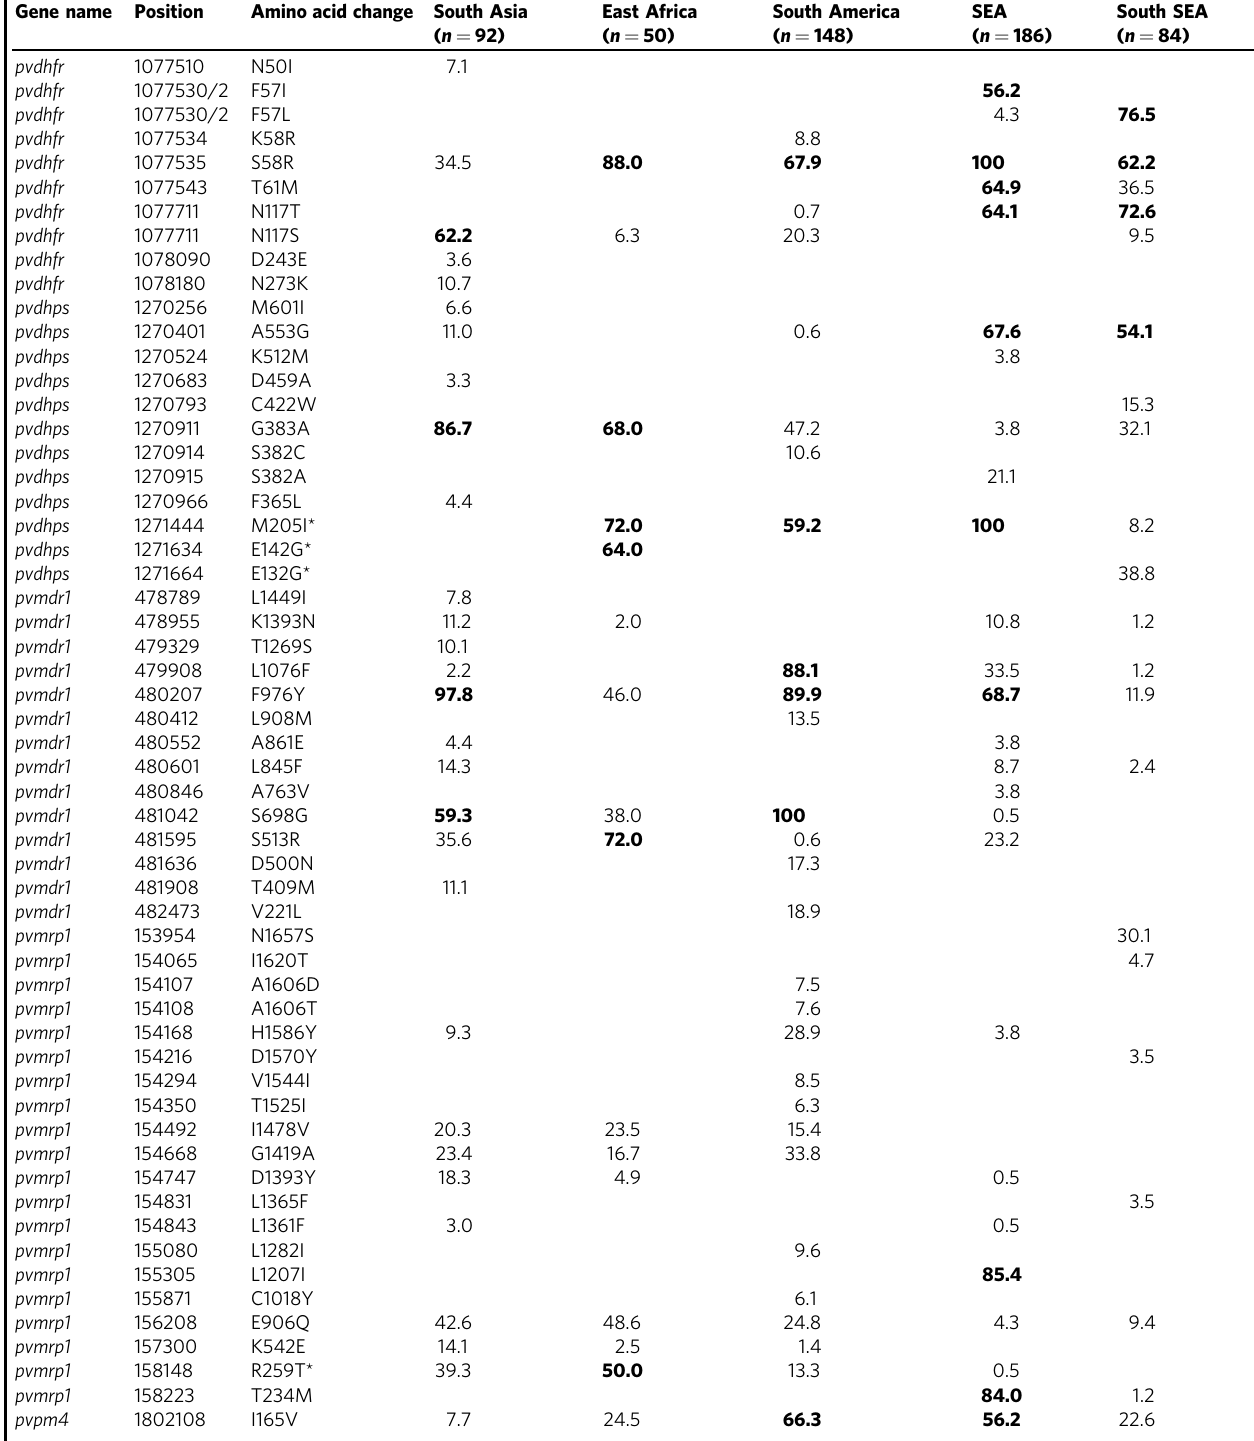
Table 2 Common mutations (allele frequency %) in putative drug-resistance genes. Gene name